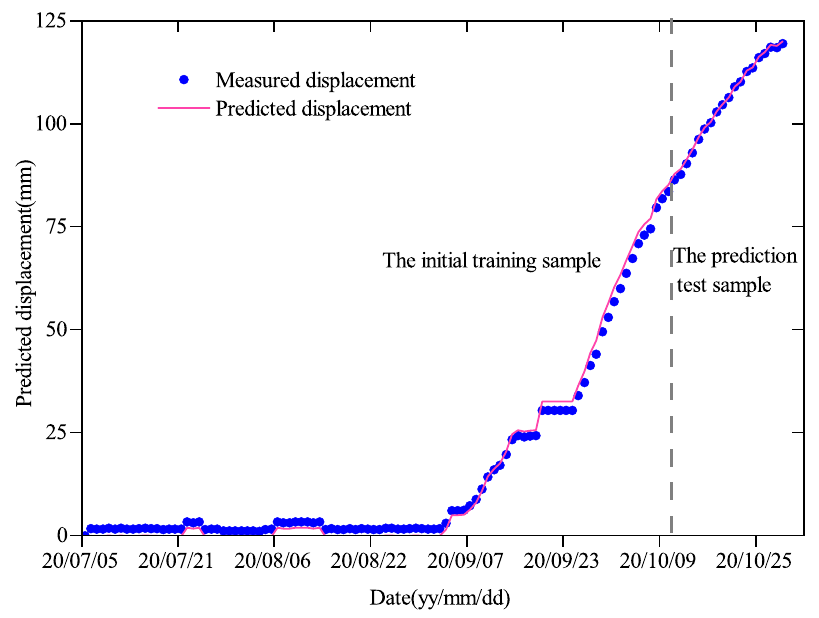
Figure 7. Prediction and comparison of measured displacement and predicted displacement by GA-Elman model.